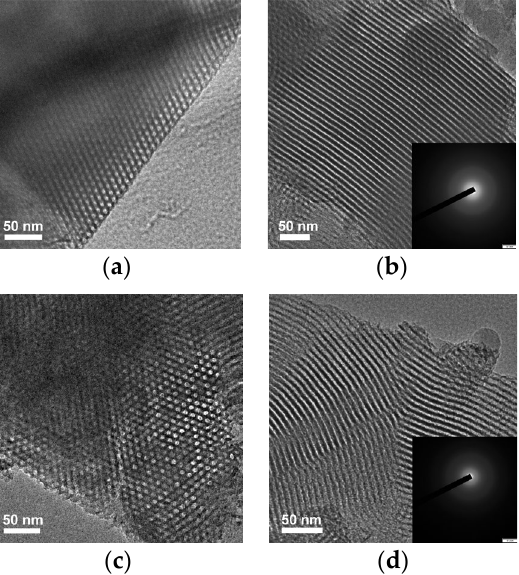
Figure 4. TEM images of Samples S - E ( a , b ) and SA - E ( c , d ) viewed along the [100] ( a , c ) and [110] ( b , d ) orientations, respectively.